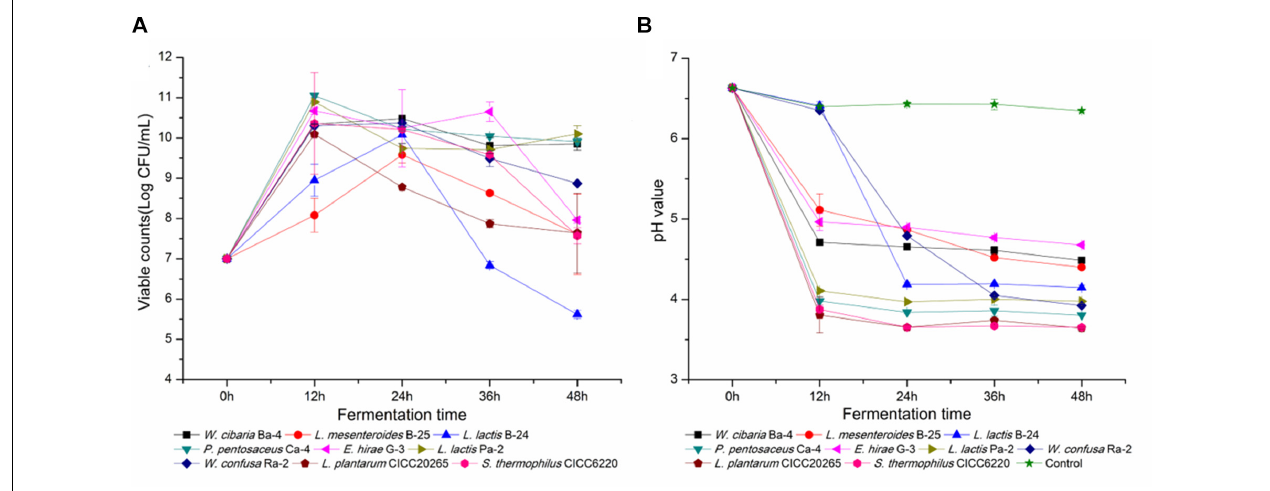
FIGURE 5 | Viable cell counts and pH values throughout the fermentation of broccoli juices incubated with the nine selected LAB strains. (A,B) Represent the change in viable cell counts and pH, respectively.